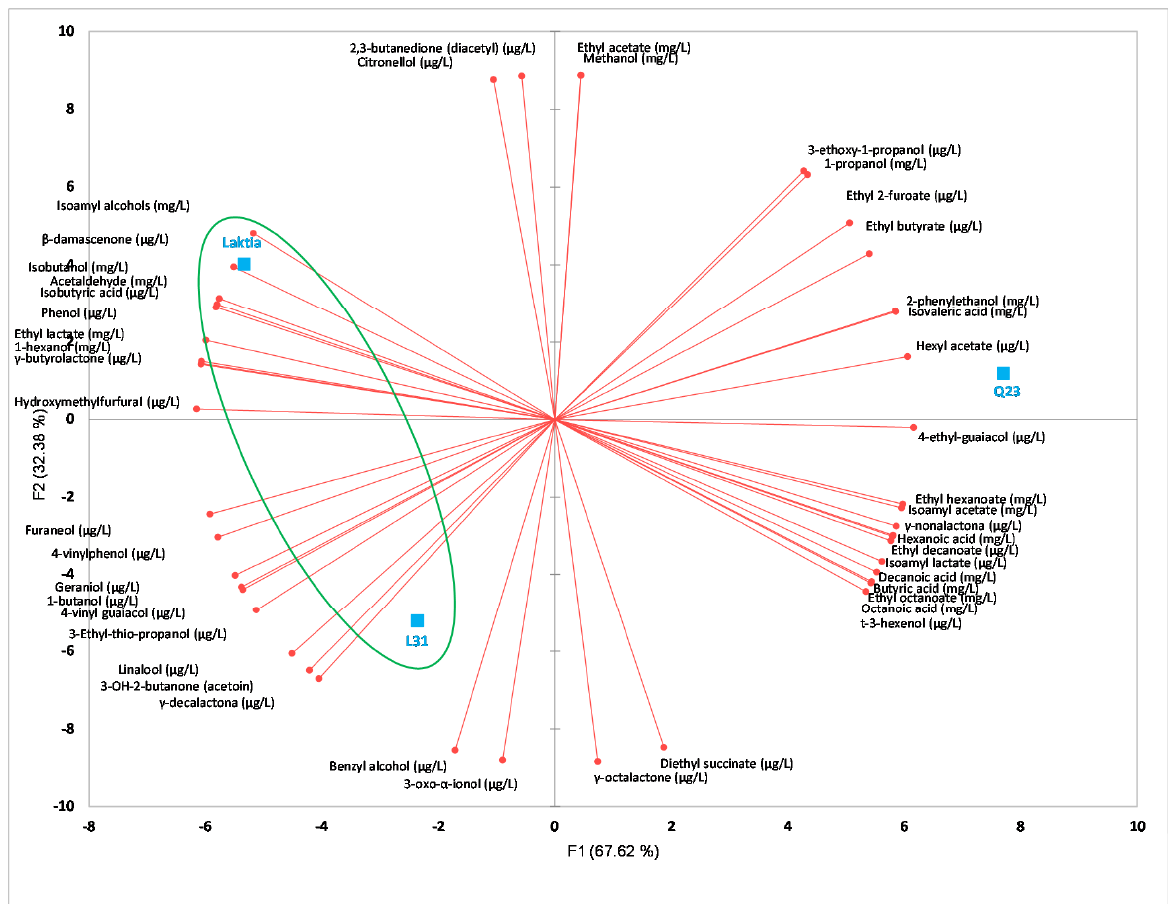
Figure 2. Principal component analysis (PCA) of the fermentative volatile